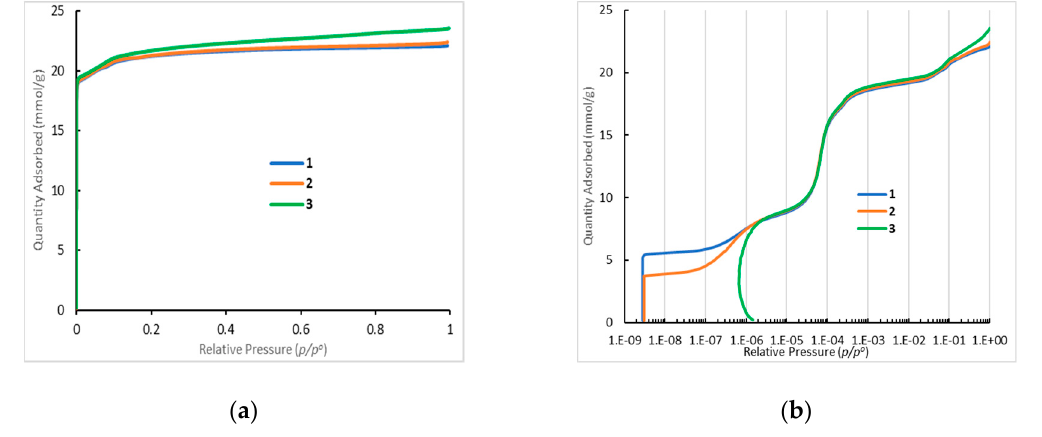
Figure 3. Complete N 2 adsorption isotherms ( a ) and their initial sections ( b ) for the HKUST-1 mw (1), HKUST-1 mw pressurized at 20 atm (2), and HKUST-1 solv.1 (3) samples measured at 77 K.